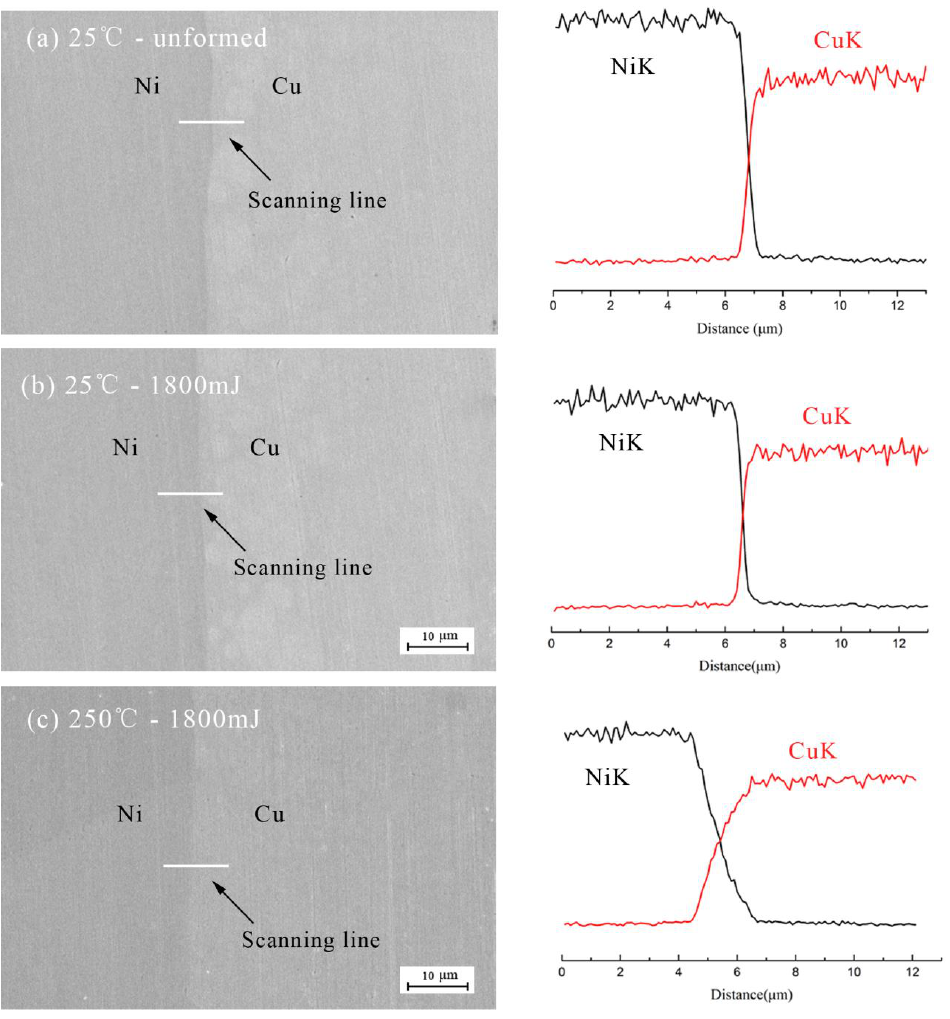
Figure 25. The results of EDX line scan: ( a ) unformed, ( b ) at 25 °C and ( c ) at 250 °C. Figure 25b,c show the composition profile before and after warm forming process at 1800 mJ,